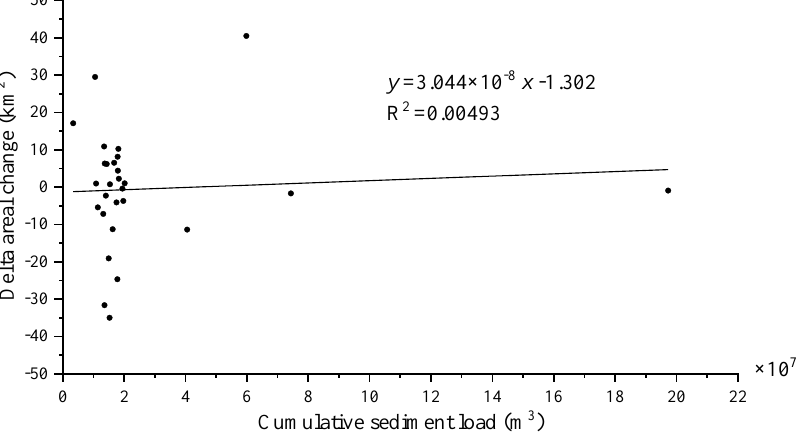
Figure 7. Relationship between the cumulative sediment load and areal change of the Volta River Delta.